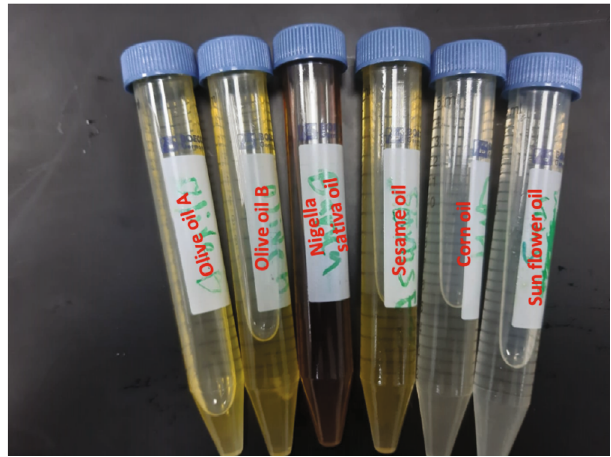
Figure 1: Oil samples used in the